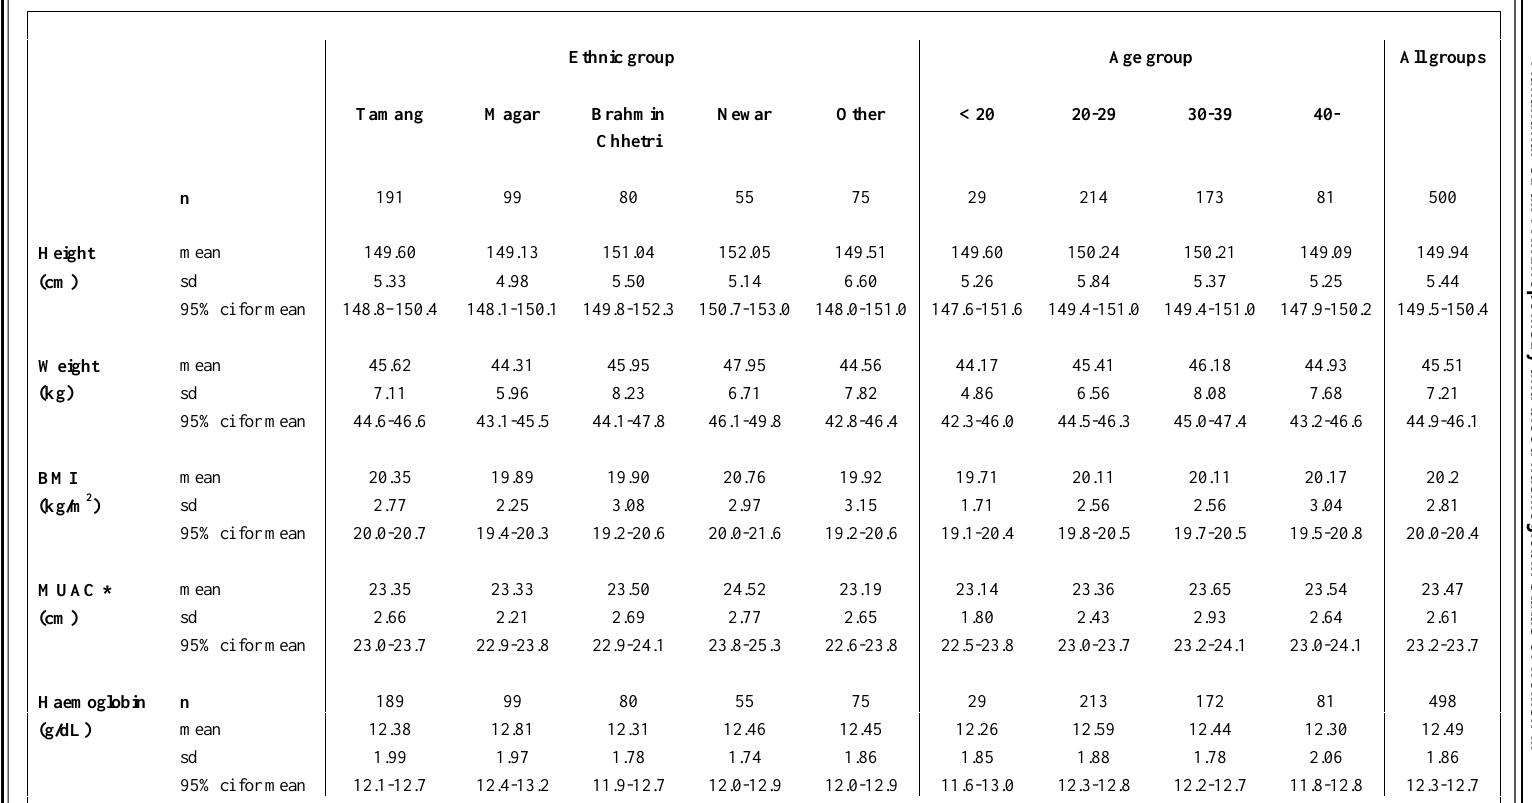
Table 1 : Height, weight, BMI, MUAC and haemoglobin for the sample, by ethnic group and age group.